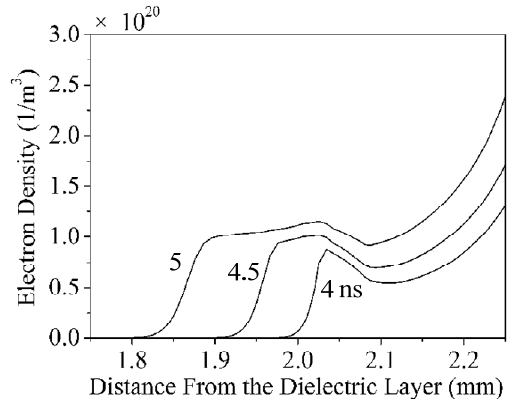
Figure 14. Electron density distribution (1/m 3 ) along the axis of symmetry of the